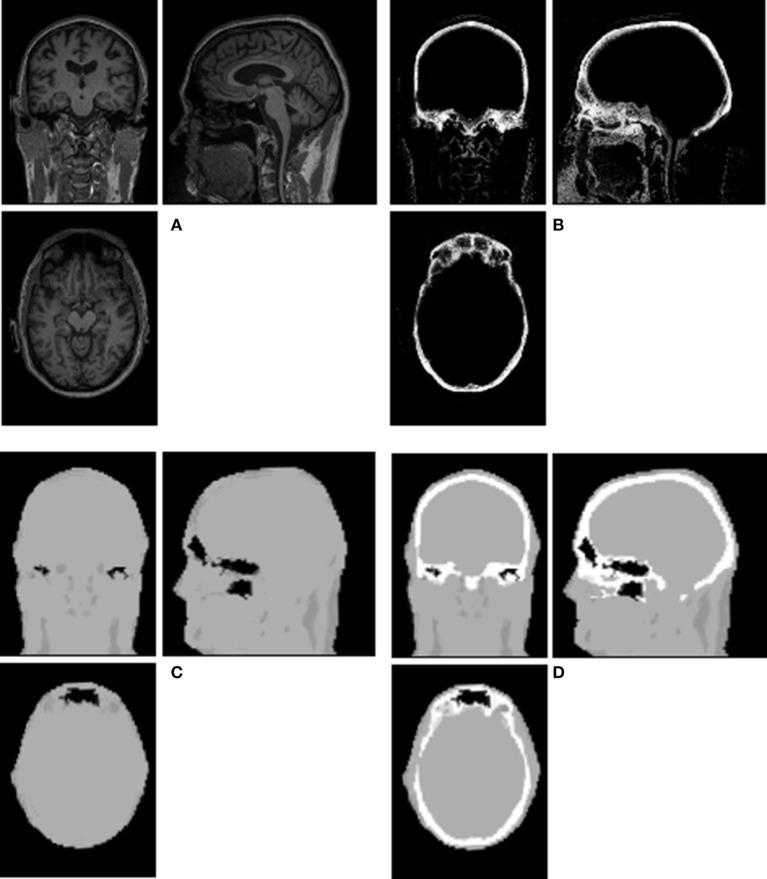
Illustration of a Dixon+bone μ-map generated in a representative subject. Images (A) T1-weighted MPRAGE, (B) bone probability map, (C) Dixon μ-map, and (D) Dixon+bone μ-map are shown in axial, coronal and sagittal views of a single slice.